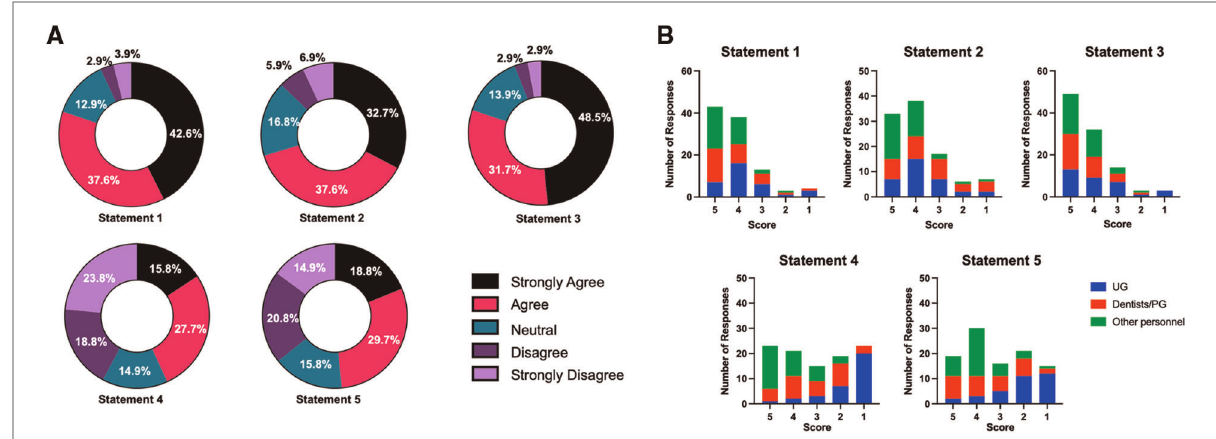
FIGURE 1 ( A ) percentage of 1 – 5 rating scale responses for each statement. ( B ) Response numbers for each faculty working status/position (1 – 5 scale) in each